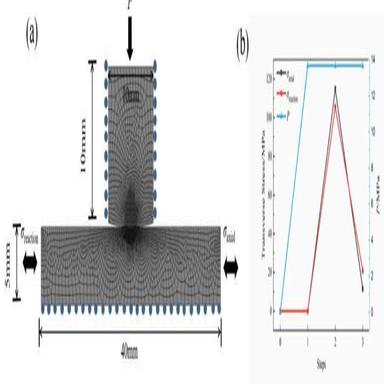
Macroscopic model; (a) FE model and (b) loading conditions.